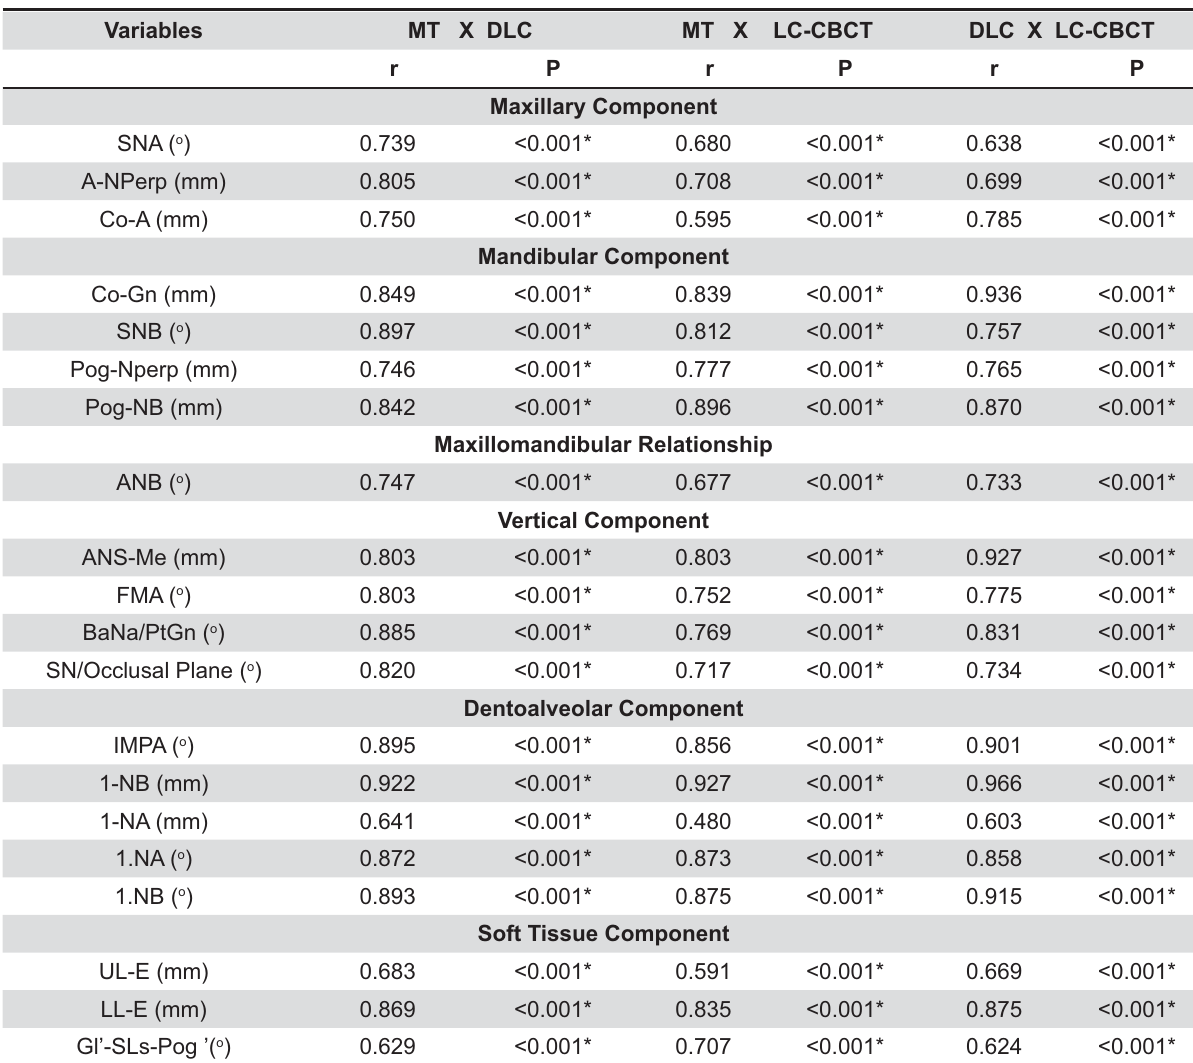
Table 4- Correlations between methods (Pearson